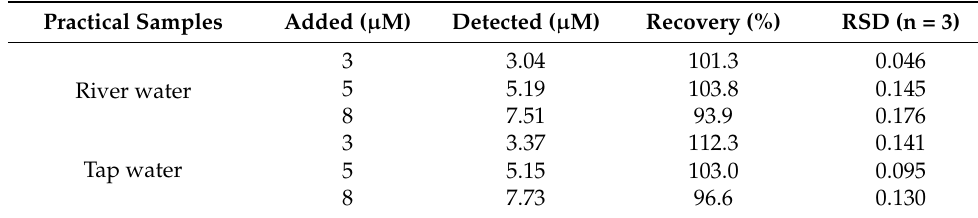
Table 2. Detection of OTC in real samples.